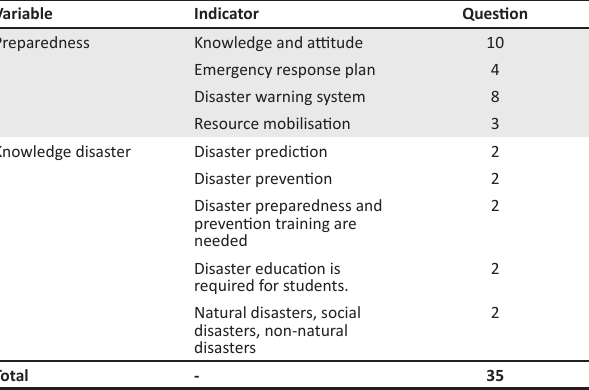
TABLE 3: Knowledge instruments and student preparedness in facing forest and land fire disasters. Variable Indicator